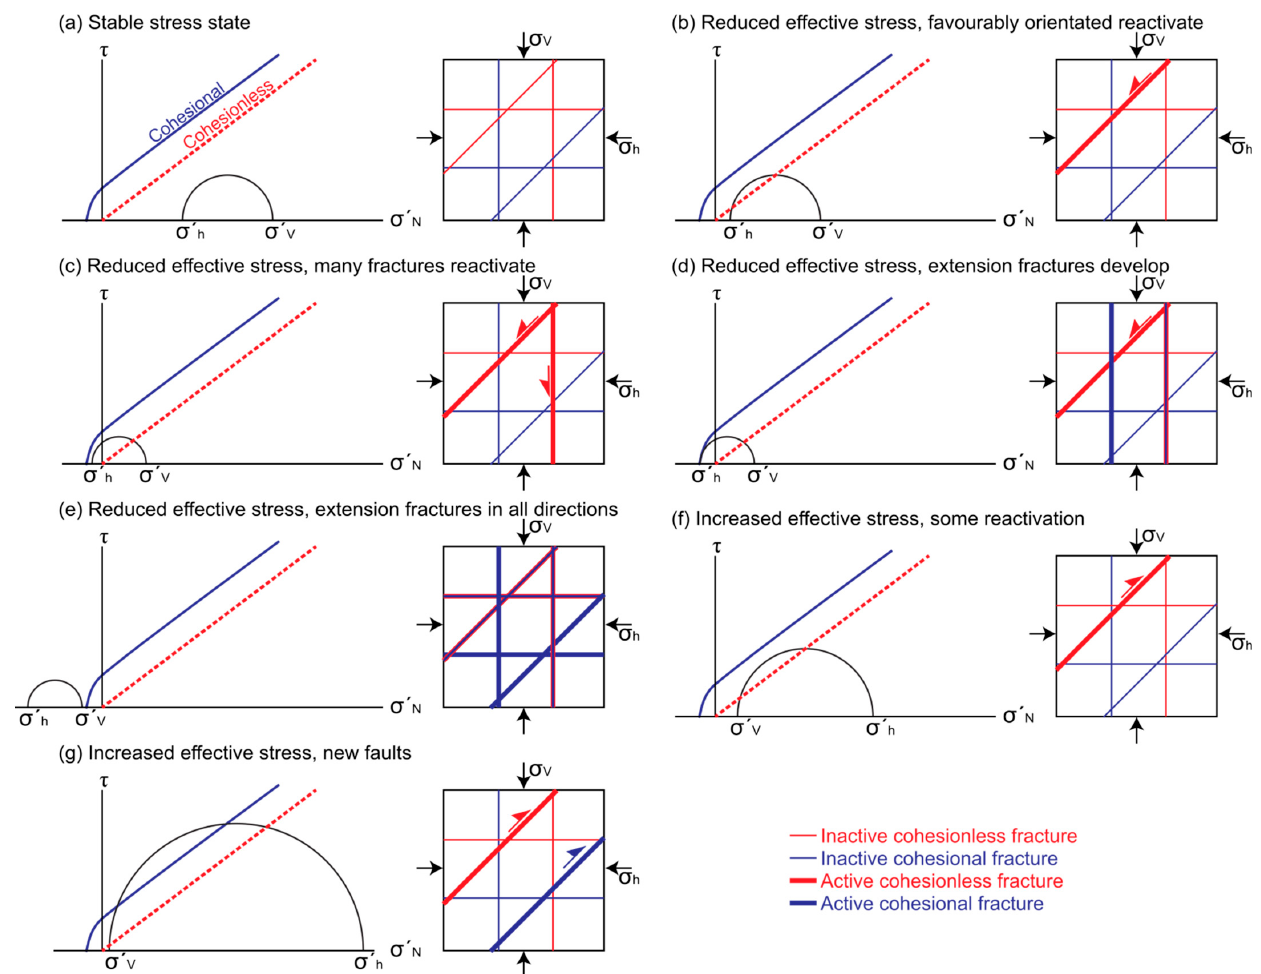
Figure 3. A range of effective stress states for fracturing illustrated using Mohr diagrams and sketch cross ‐ sections with cohesive fractures (e.g., veins) and non ‐ cohesive fractures (e.g., joints) dipping at 90°, 45°, and 0°. σ V = vertical stress, σ h = horizontal stress. ( a ) Stable stress state, in which the effective stresses are insufficient to reactivate existing fractures or create new fractures. ( b ) Reduced effective stresses, such that favourably-orientated pre-existing cohesionless fractures can be reactivated as shear fractures. ( c ) Reduced effective stresses, such that favourably-orientated pre-existing cohesionless fractures can be reactivated as shear fractures. ( d ) Reduced effective stresses, such that new extension fractures are created perpendicular to the least effective stress. ( e ) Reduced effective stresses (e.g., as fluid pressure increases), such that new extension fractures with any orientation can be created. ( f ) Increased effective stresses, such that favourably-orientated pre-existing cohesionless fractures are reactivated as shear fractures. ( g ) Increased effective stresses, such that new shear fractures are